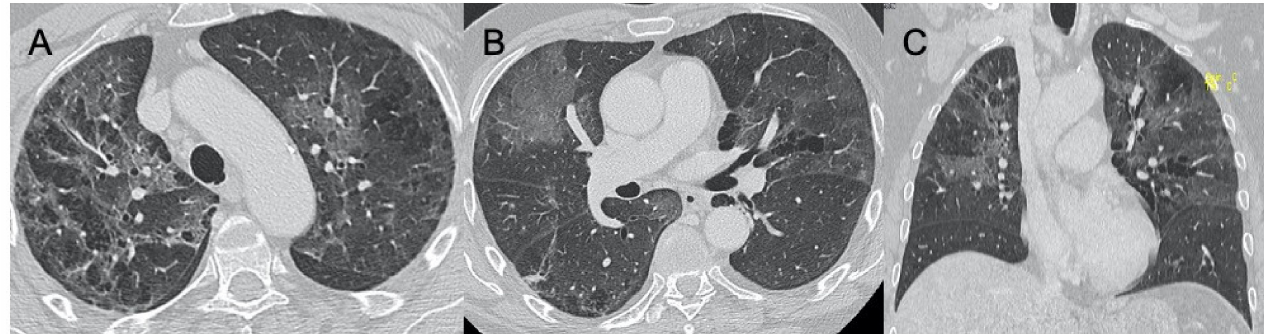
Figure 6. Herpes virus pneumonia. A case of HSV (Herpes virus) ( A – C ) pneumonia with bilateral ground-glass opacities with patchy distribution, mainly in both upper